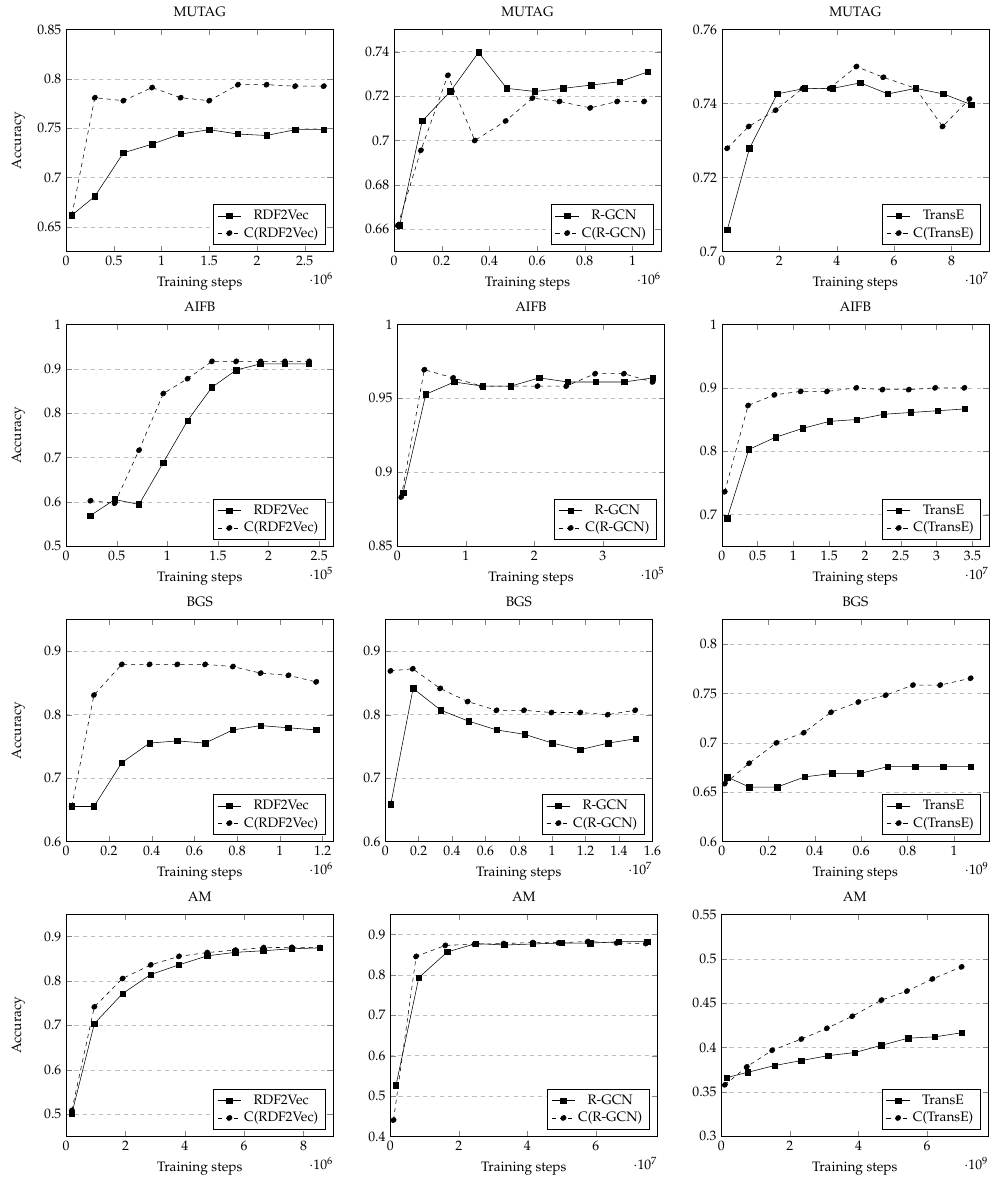
Figure 2. Pairwise comparison between the baseline method and our strategy demonstrating perfor- mance (accuracy) as a function of the number of training steps performed for each